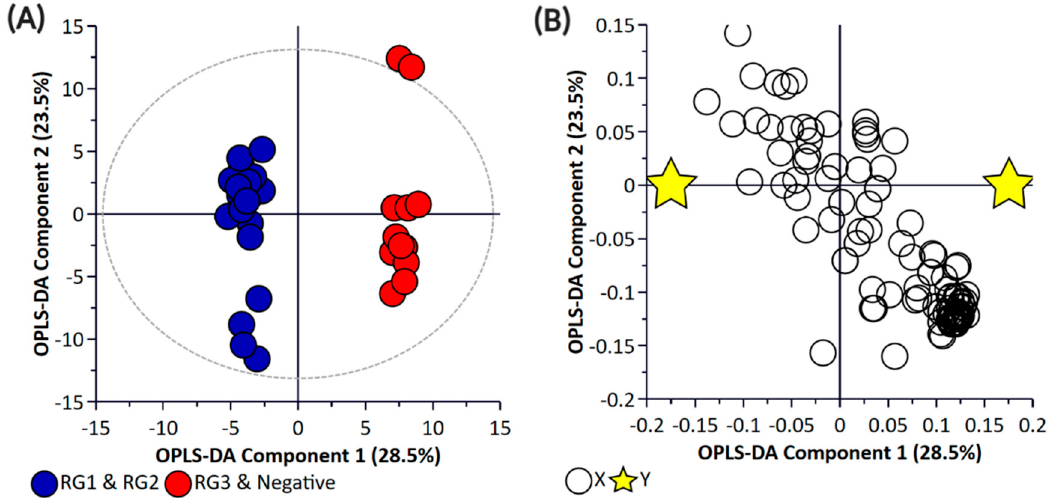
Figure 3. Orthogonal Partial Least Square-Discriminant Analysis ( A ) scatter plot and ( B ) loading plot of bacterial super- natant samples collected from BPW cultures ( n = 36; note, the negative group includes Salmonella). R 2 X (cum) = 0.744, R 2 Y (cum) = 0.987, Q 2 = 0.751. Note, the ellipse presented in Figure 3A represents Hotelling’s T 2 confidence limit (95%). Note: The colored circles in panel “A” represent each analyzed sample, while the yellow-colored stars in panel “B” indicate the average group position for each sample cluster, with the white circles representing the distribution of metabolite features between these groups.